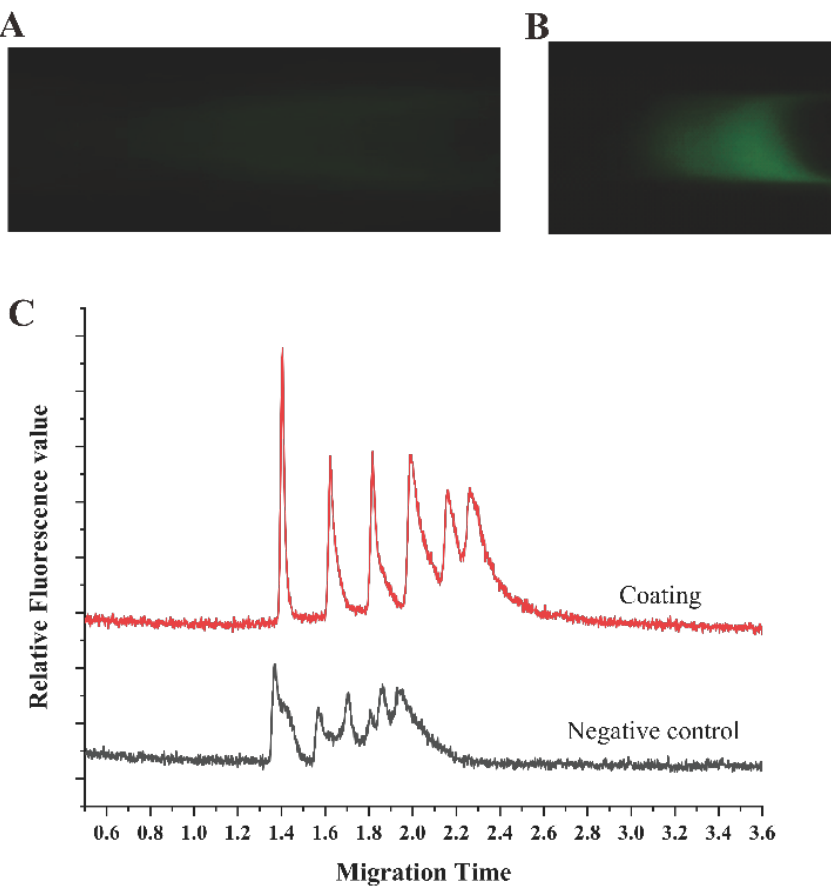
Figure 3. The fluorescence of DNA banding during electrophoresis in ( A ) uncoated microchannels and ( B ) coated microchannels. ( C ) The electropherogram of 100 bp DNA ladder in the coated and uncoated microchannel.